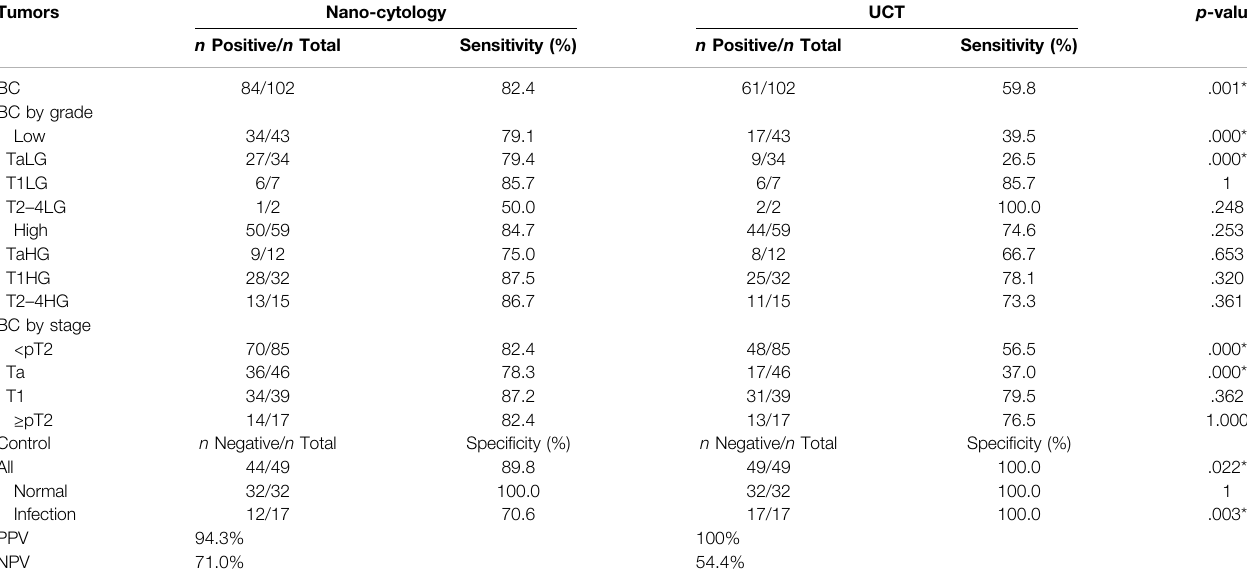
TABLE 2 | Detailed comparison of sensitivity obtained by Nano-cytology and UCT for BCa detection in relation to tumor stages and grades.